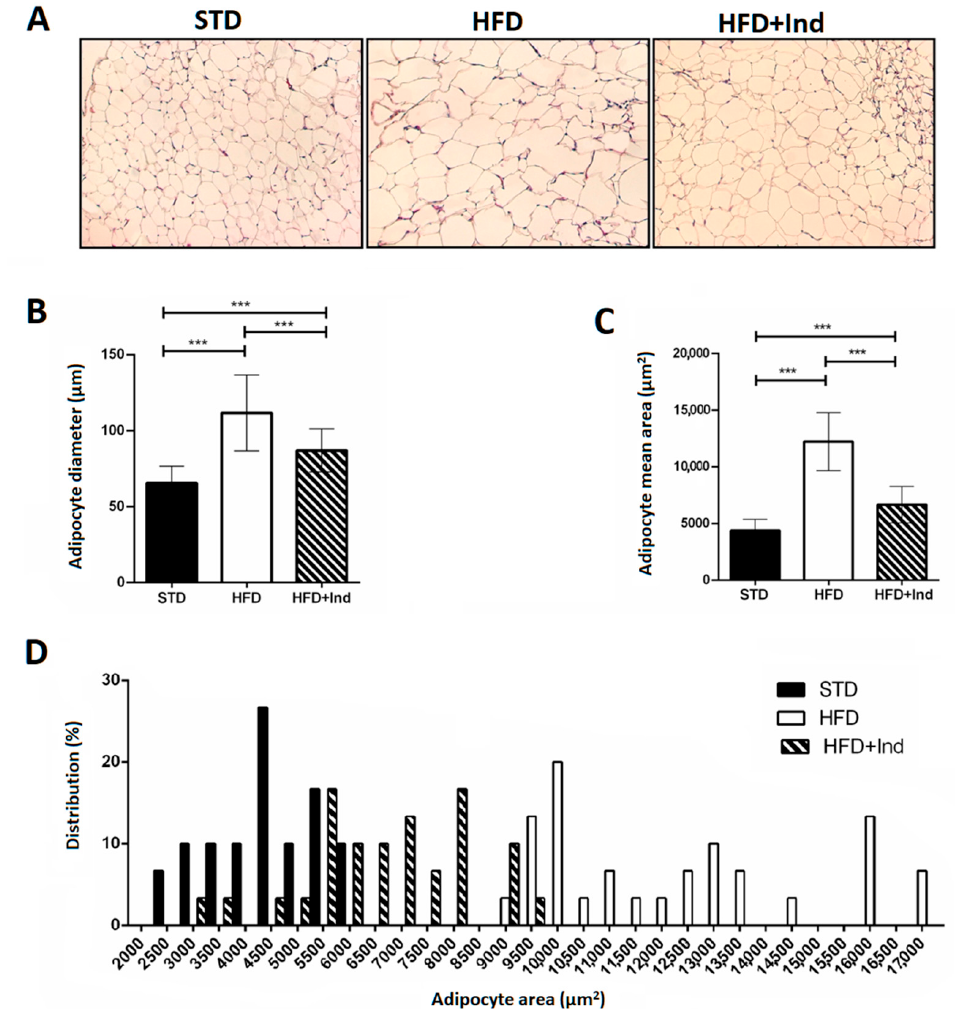
Figure 2. Indicaxanthin treatment reduces visceral adipose tissue hypertrophy in HFD mice. Histological cross-sections of visceral adipose tissue ( A ), adipocyte diameter ( B ), area ( C ) and size distribution (%) ( D ) in the different animal groups. Results are shown as means ± SEM of 8 animals/group. *** p ≤ 0.001. (ANOVA associated with Bonferroni’s correction).